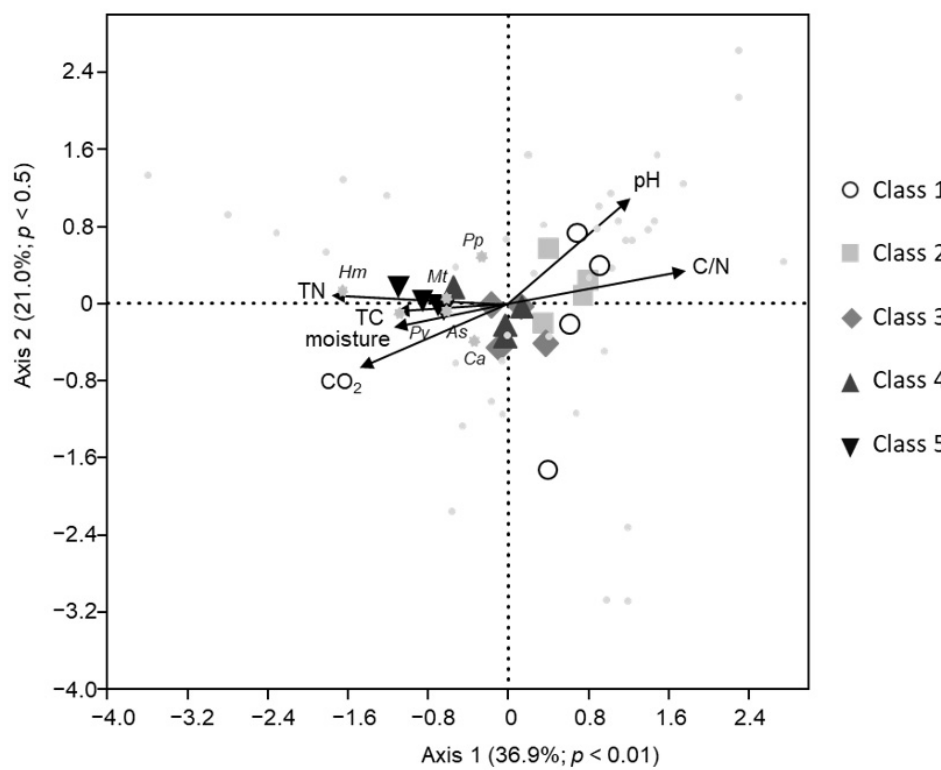
Figure 5. Canonical correspondence analysis (CCA) ordination diagram of ciliate community and environmental variables defined by the first and second axes. DGGE band scores were also plotted as light grey dots; bands that significantly contribute to separate last decay classes were plotted as stars: Holosticha multistylata ( Hm ); Platyophrya vorax ( Pv ); Mykophagophrys terricola ( Mt ); Anteholosticha sigmoidea ( As ); Colpoda aspera ( Ca ); Paraholosticha pannonica ( Pp ). Vectors represent deadwood moisture, pH, deadwood total C content (TC), deadwood total N content (TN), deadwood C/N ratio, and CO 2 flux from deadwood cores. The percentage of the variation in the data and significance is reported at each axis.